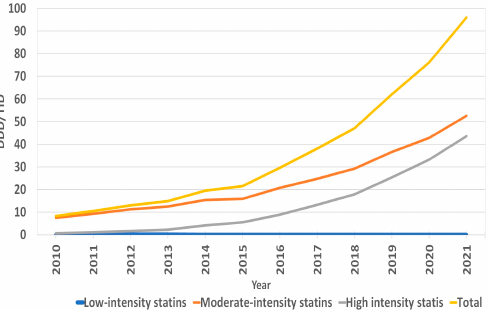
Figure 1. Annual sales of statins in DDD/TID according to therapy intensity.